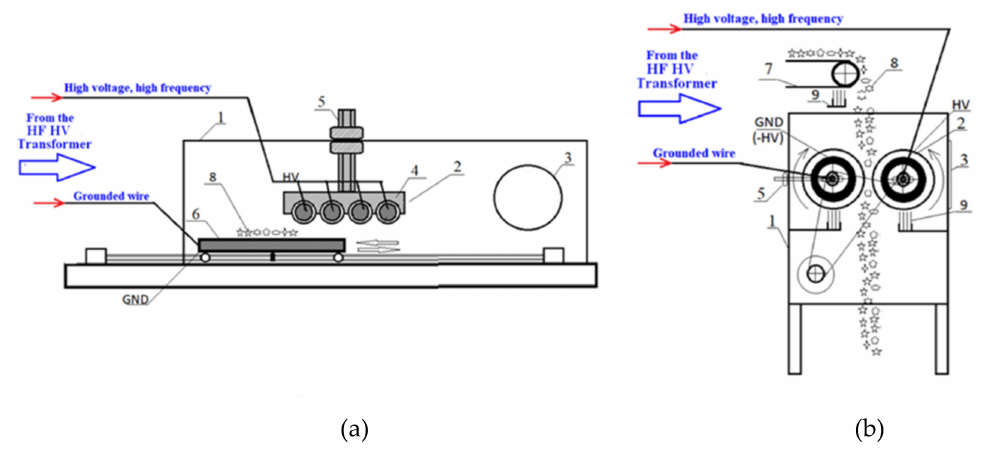
Figure 1. View of devices for decontamination of loose organic materials using DBD discharges tested by the authors: ( a ) device with a sliding electrode; ( b ) device with rotating electrodes; 1—discharge chamber, 2—electrodes assembly, 3—transport trolley, 4—operator panel, 5—electrodes gap adjustment knob, 6—ozone chamber and 7—belt conveyor (adapted from Mu´cko et al. [28]).